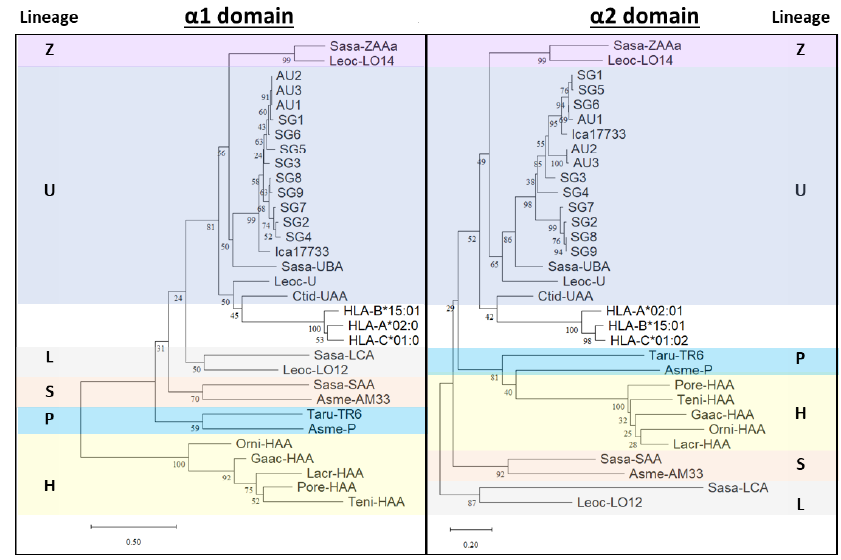
Figure 3. Phylogenetic trees based on α 1 and α 2 domain amino acid sequences of Asian seabass and other representative teleost fishes’ MHC-I molecules. Neighbor-joining tree [32] of α 1 (left tree) and α 2 (right tree) domain sequences. The trees are drawn to scale, with branch lengths indicating the number of amino acid substitutions per site. The percentage of replicate trees in which the associated taxa clustered together in the bootstrap test (1000 replicates) [33] is shown on each node. The evolutionary distances were computed using the Poisson correction method [34] and are presented in the unit of the number of amino acid substitutions per site. The analysis involved 32 amino acid sequences. There were 99 positions in each of the final datasets. Evolutionary analyses were conducted in MEGA11 [35]. Clusters with the six different MHC class I lineages found in teleosts are shown with colored boxes. The sequence references are listed in Figure 1.